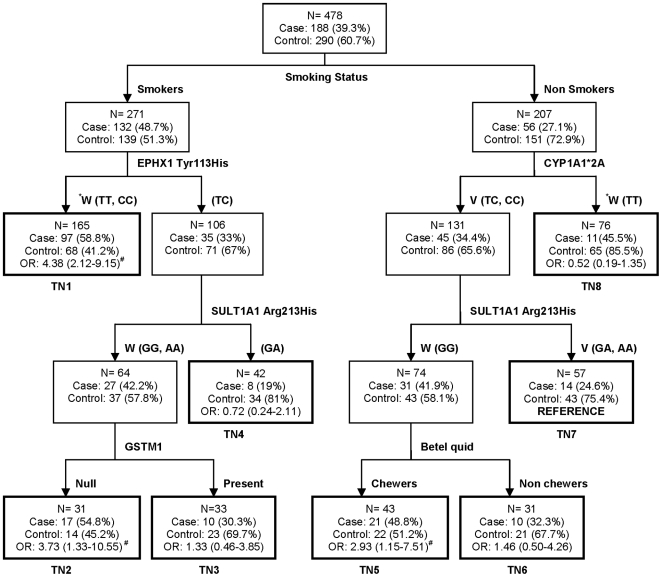
Classification and regression tree model for xenobiotic metabolizing gene polymorphisms and environmental risk factors.Terminal nodes are thick bordered. *W: Wild type genotype; V: Variant genotype, TN: Terminal Node, #p value <0.05